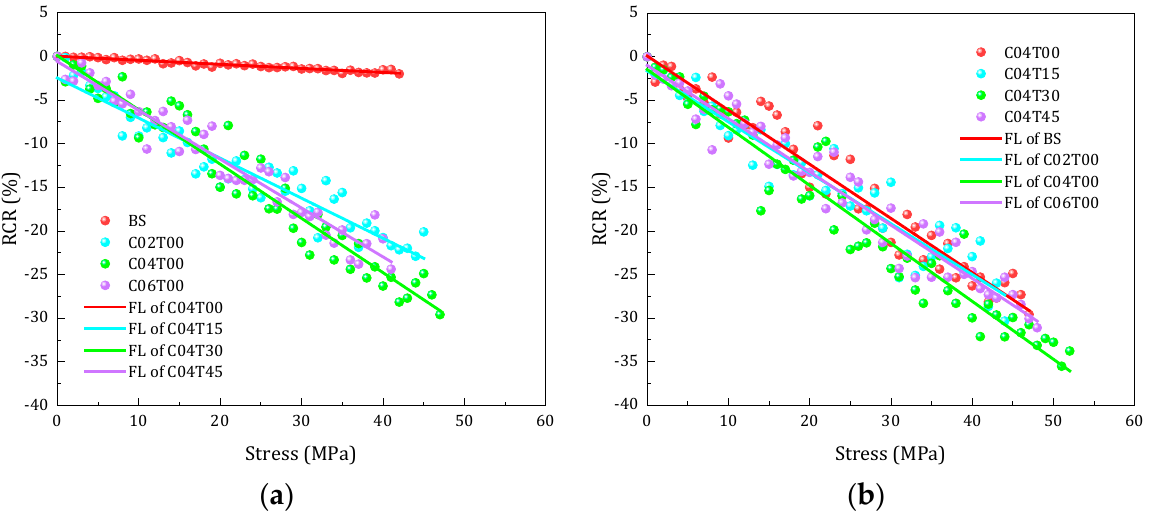
Figure 8. Stress–RCR fitting curves of cement-based composites before freeze-thaw cycles. ( a ) Stress–RCR curves of BC, C 02 T 00 , C 04 T 00 , C 06 T 00 ; ( b ) stress–RCR curves of C 04 T 00 , C 04 T 15 , C 04 T 30 , C 04 T 45.